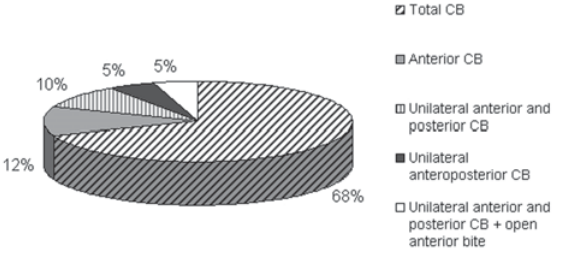
FIGURE 1- Distribution of patients according to type of crossbite (CB) at the presurgery